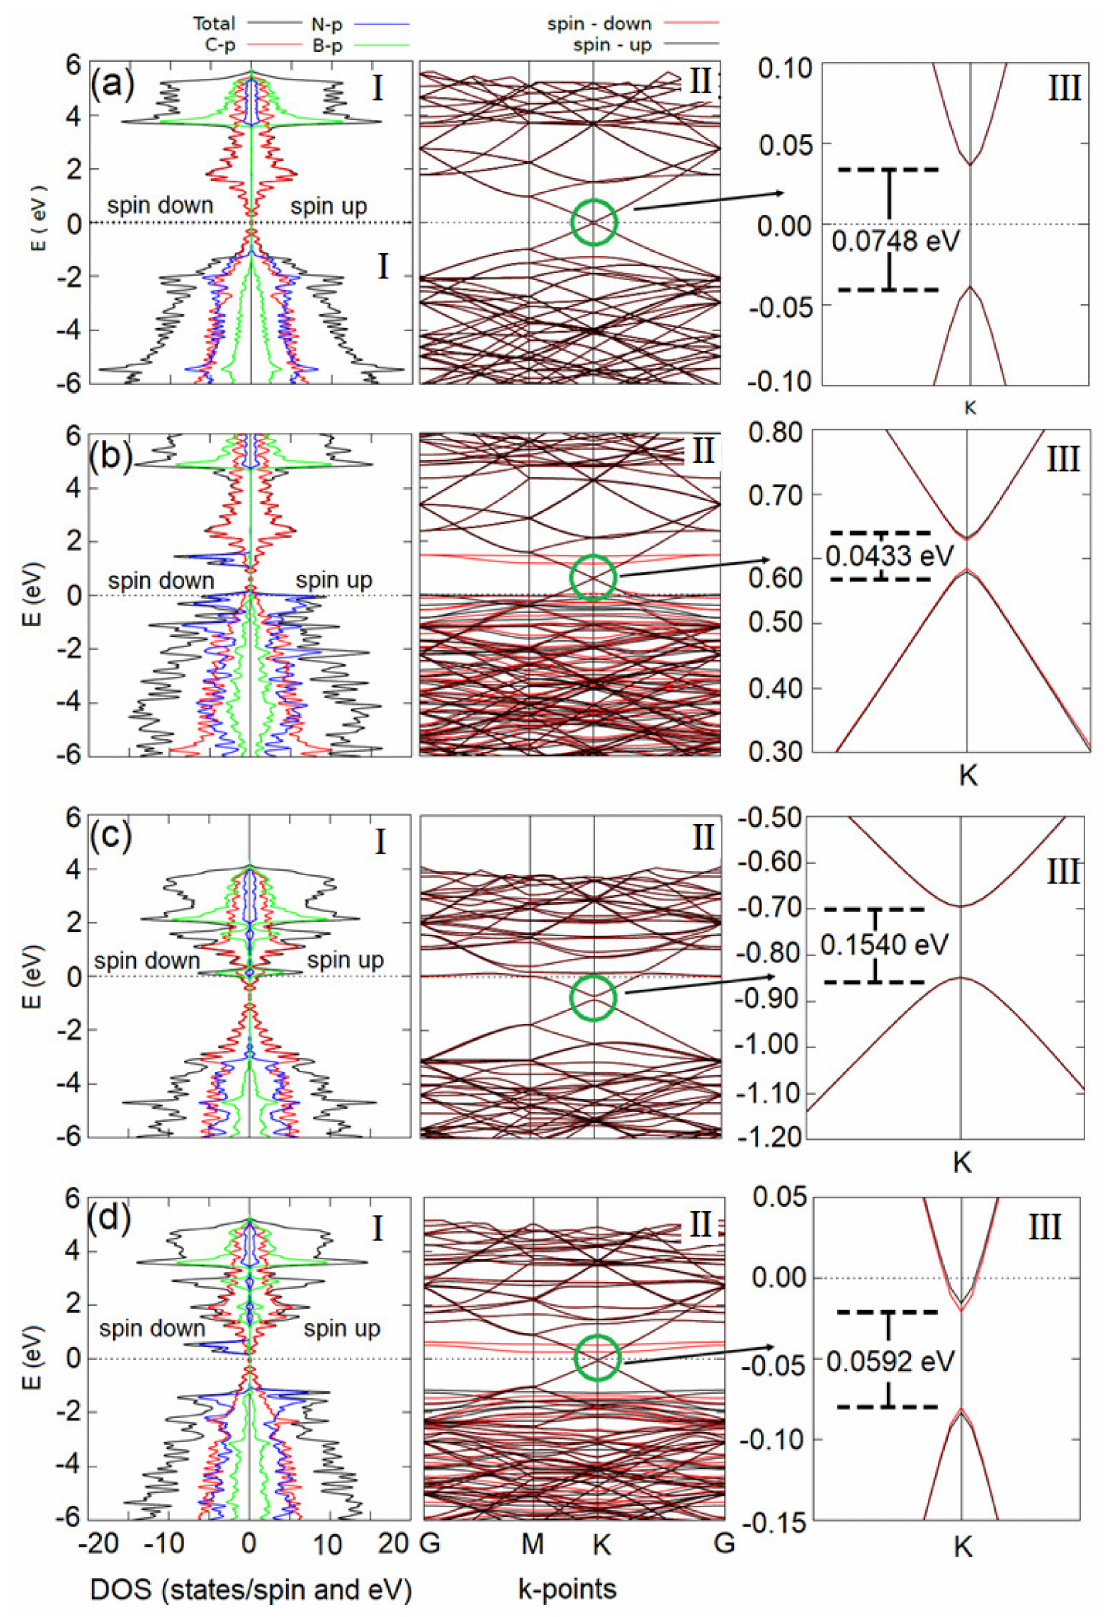
Figure 4. The BE and DOSs of the heterobilayer ( a ) without vacancy, ( b ) 1 V B , ( c ) 1 V N , and ( d ) co- vacancy V BN ,